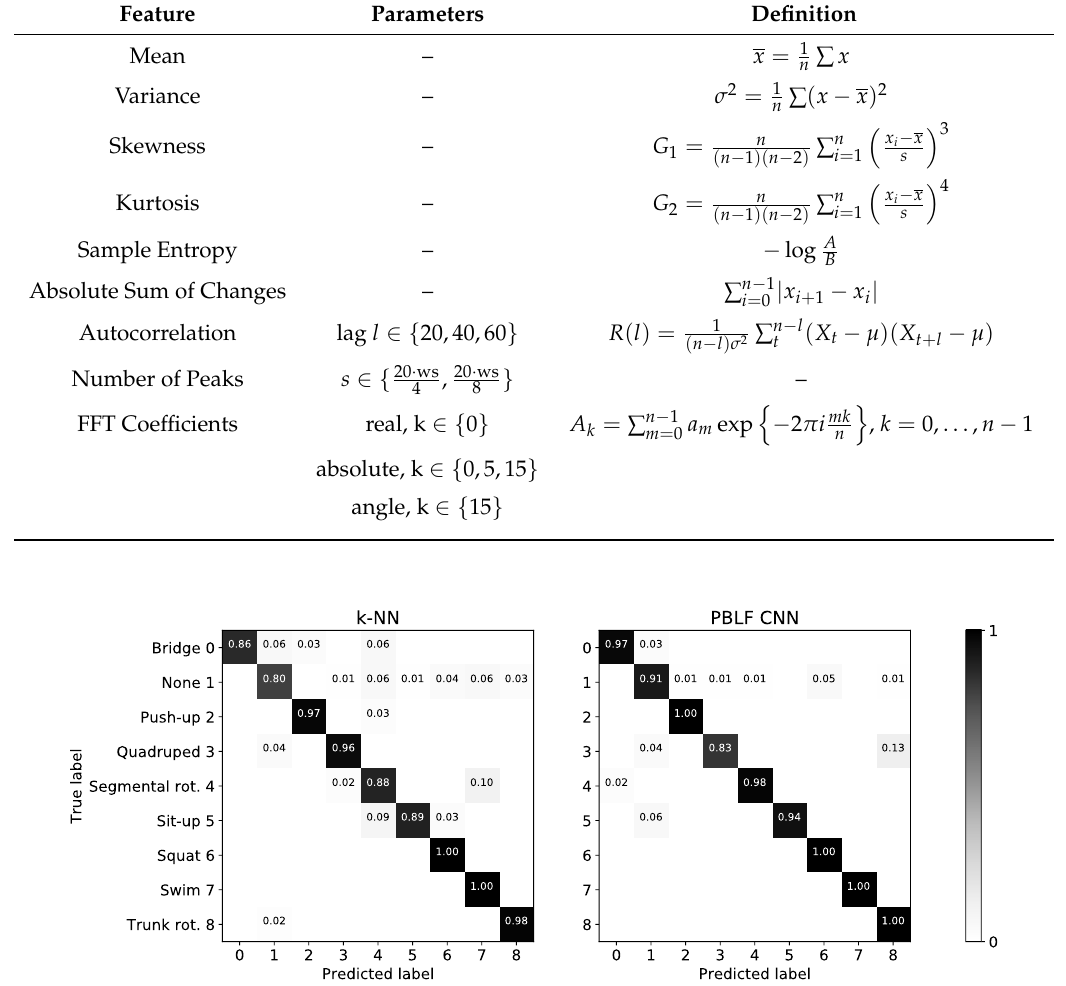
Table A1. The extracted features for every sensor channel, resulting in 120 features total for a time series segment.